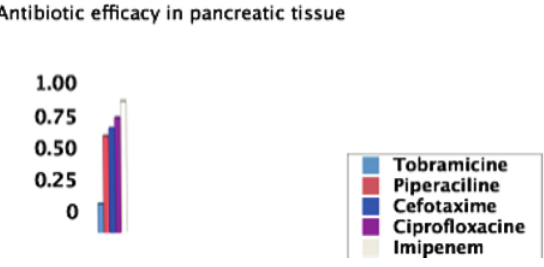
Figure 2. Antibiotic effi cacy in pancreatic